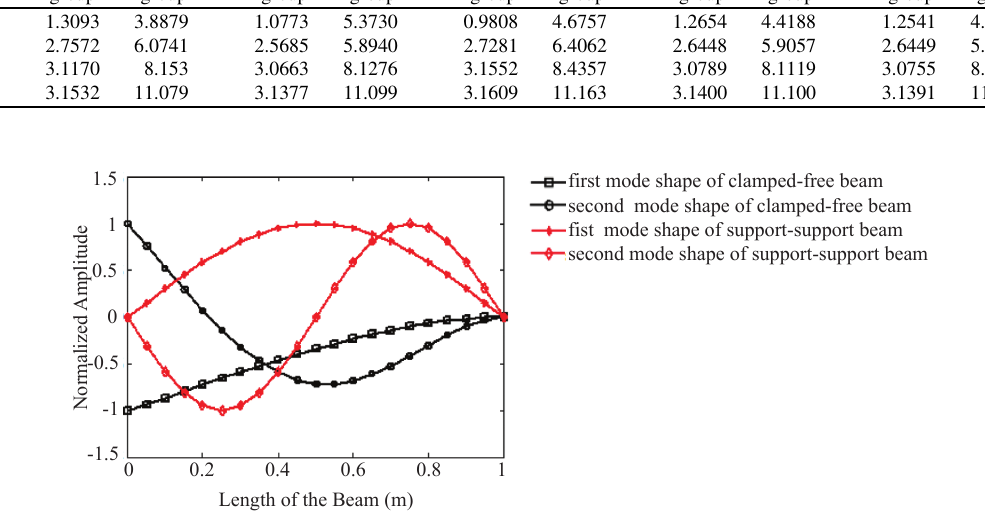
Fig. 3. Mode shapes of simply-simply supported and clamped-free beam without spring-mass